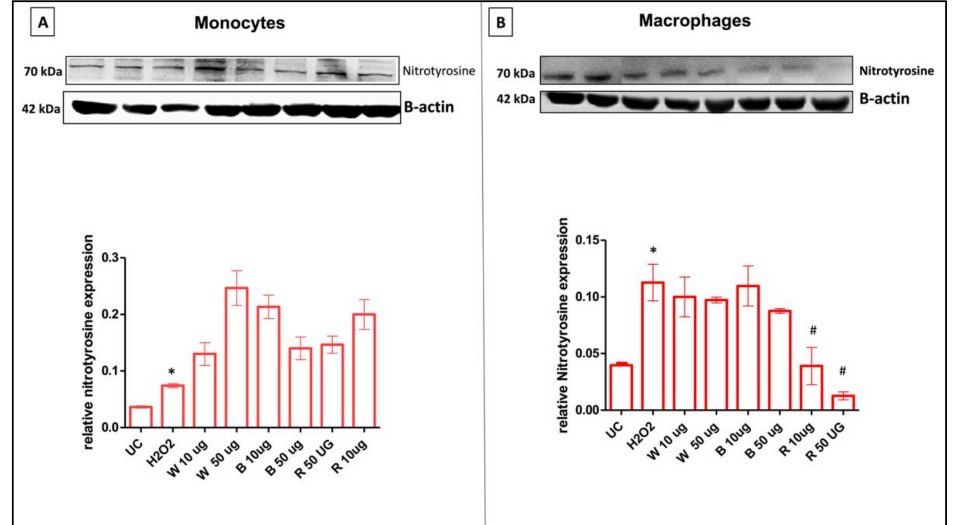
Figure 6. Nitrotyrosine protein expression in undifferentiated (monocytes) and differentiated (macrophages) cells. Effect of different doses (10 and 50 µ g/mL) of garlic extracts after 24 h of incubation on the expression of 3-nitrotyrosine protein in H 2 O 2 stimulated cells. Representative image of Western blot experiment on undifferentiated (monocytes) cells ( A ) and differentiated cells (macrophages) ( B ) (top). At the bottom, averaged band density of protein normalized vs. β -actin. The data represented means ± SD ( n = 3). * p < 0.05 vs. UC; # p < 0.05 vs. H 2 O 2 -treated